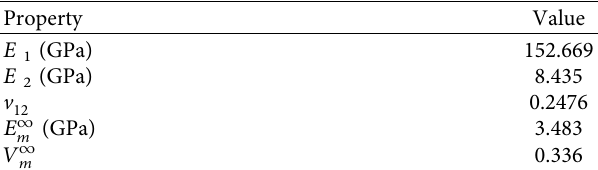
Table 4: Mechanical properties of composite and cured resin. Property